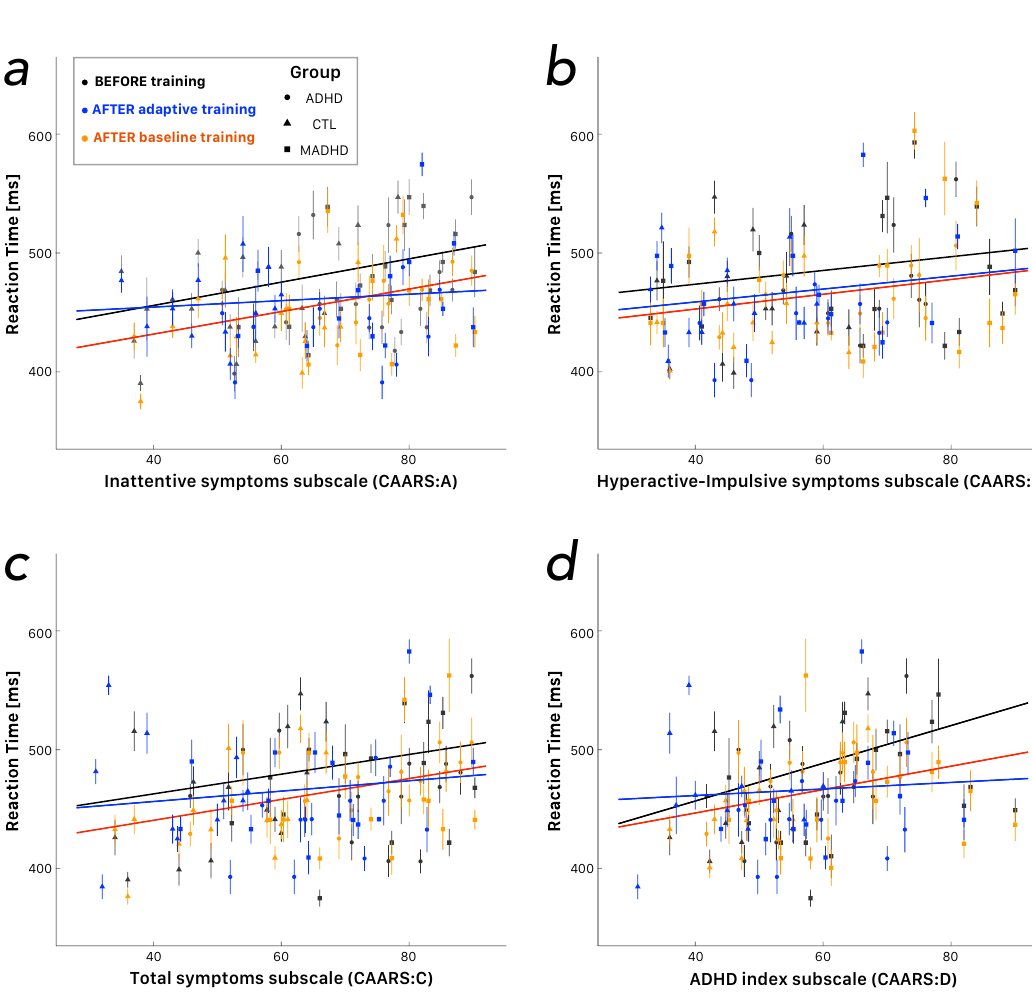
Figure 3. Dimensional analysis of reaction times as a function of the severity of ADHD symptoms measured by Conners’ Adult ADHD Rating Scales-Self Report (Screening Version, CAARS-S:SV). ( a ) Scatterplot as a function of CAARS:A ( DSM-IV Inattentive Symptoms Subscale ). ( b ) Scatterplot as a function of CAARS:B ( DSM-IV Hyperactive-Impulsive Symptoms Subscale ). ( c ) Scatterplot as a function of CAARS:C ( DSM-IV Total ADHD Symptoms Subscale ). ( d ) Scatterplot as a function of CAARS:D ( ‘ADHD Index’, the normalized T-score of CAARS ). Each point shows the median and the median absolute deviation for one participant. Participants’ groups are identified by distinct shapes, i.e., triangles for controls, circles and squares for non-medicated and medicated ADHD patients, respectively. Data points before training (all subgroups merged together) are plotted in black. Data points after training are plotted in red for the baseline level (fixed at 1-back) and in blue for the adaptive level of the Dual n -back. Color lines refer to the robust regression of the corresponding data points. Notice that the slope for participants before training and after baseline training tended to be very similar. Notice also that the slopes tended to flatten after adaptive training, irrespective of the CAARS